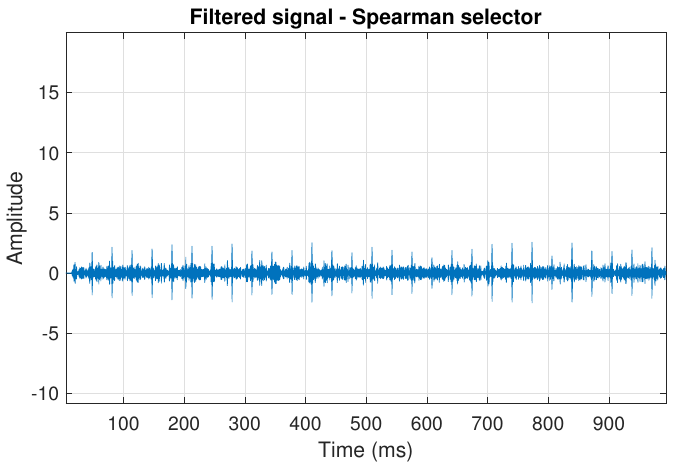
Figure 9. Filtered signal s 1 by Spearman